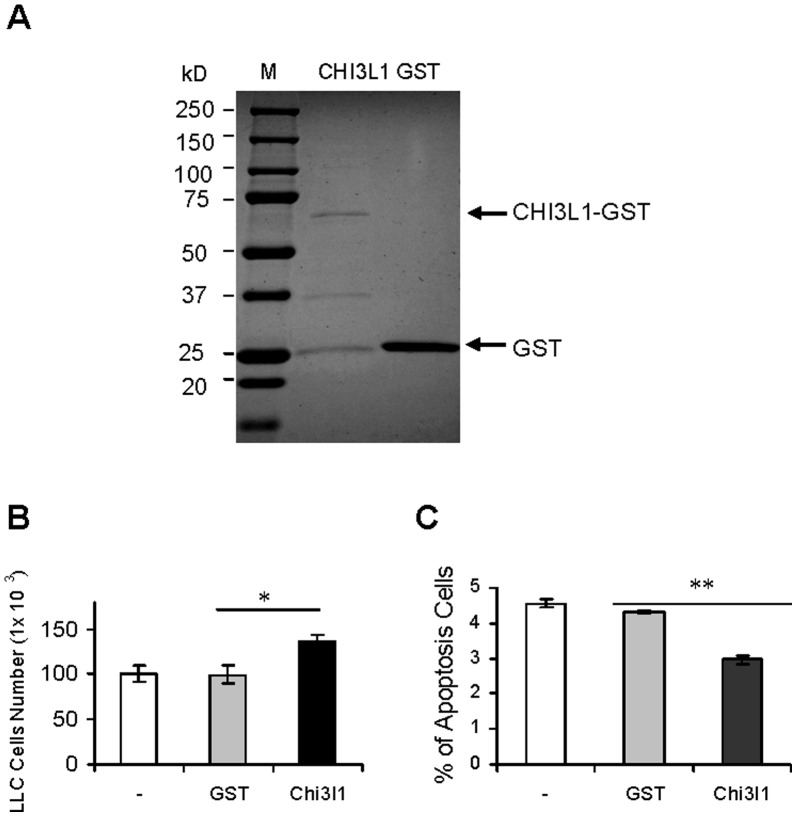
Stimulatory effect of CHI3L1 on tumor cells in vitro.
A) Purity of recombinant CHI3L1-Flag fusion protein (upper arrow); B) LLC cell proliferation treated with GST or CHI3L1-GST fusion protein; C) The apoptotic activity of LLC cells treated with GST or CHI3L1-GST fusion protein by Annexin V labeling assay. *, p<0.05, **, P<0.01.